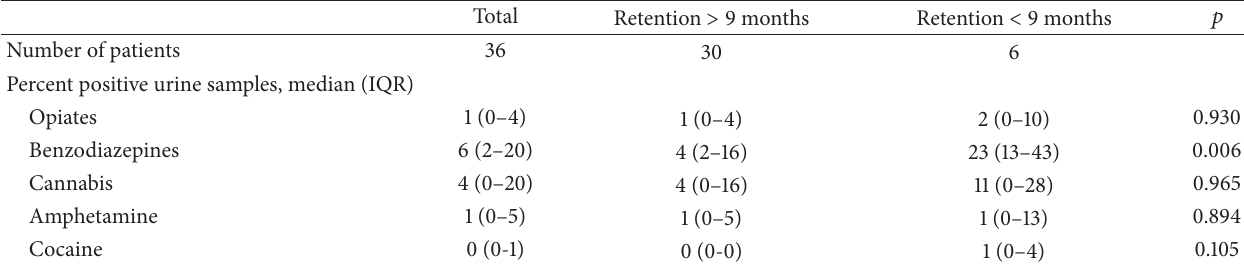
Table 3: Urine samples in full-scale OMT in relation to 9-month